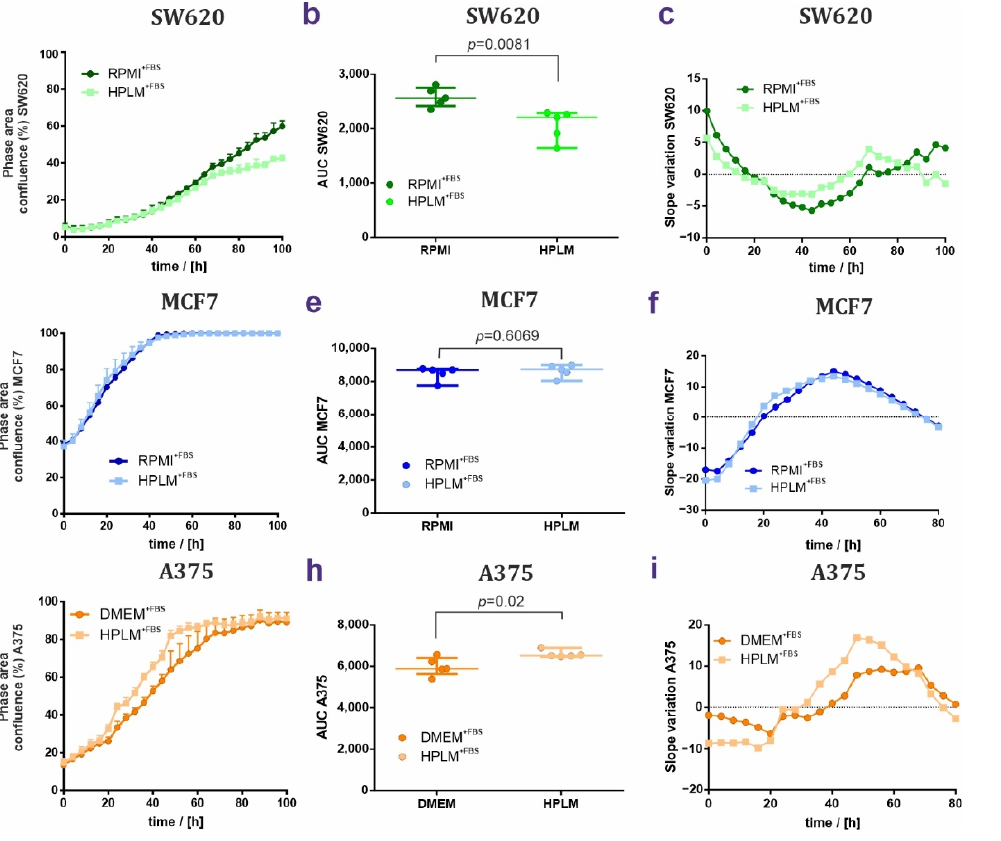
(3) Respiration in all coupling control states—with major effects on ROUTINE respiration and ET capacity—was increased in A375 melanoma cells cultured in HPLM +FBS compared to DMEM +FBS (Figure 3e,f). Results are summarized in Table S1a.